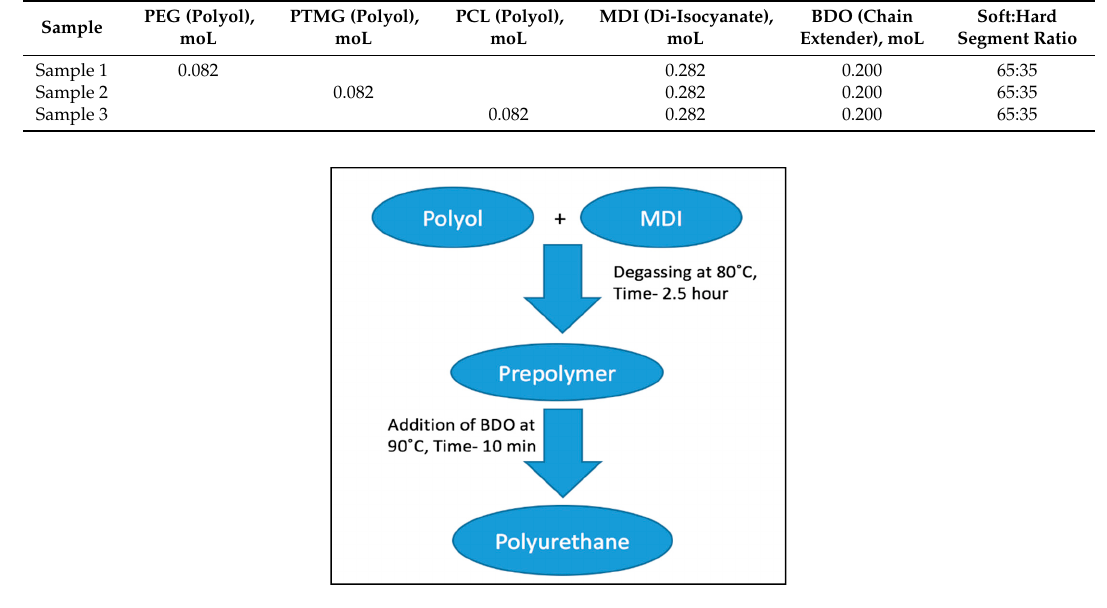
Figure 1. Synthesis procedure of polyurethane.